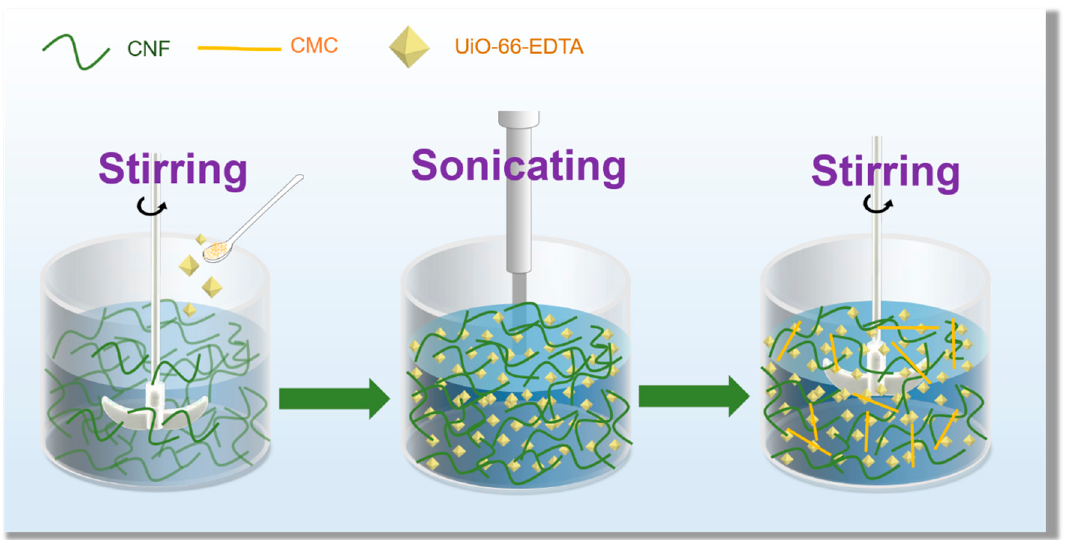
Figure 1. Experimental process of the UiO-66-EDTA-containing a cellulose nanofiber (CNF) suspension.